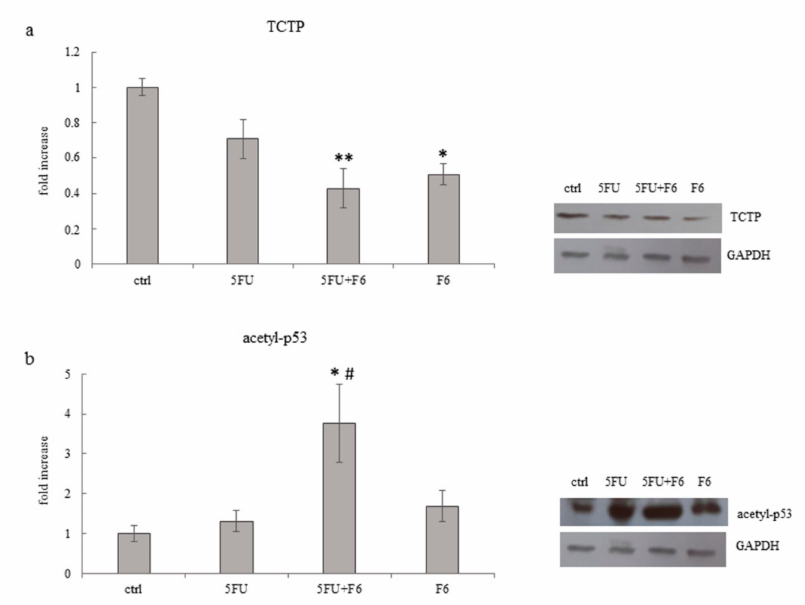
Figure 9. E ff ect of 5FU, 5FU + F6, and F6 on expression of TCTP ( a ) and acetyl-p53 ( b ) in MDA-MB-231 cells. Columns represent densitometric quantification of optical density (OD) of specific protein signal normalized with the OD values of GAPDH served as a loading control and they are expressed as fold increase of control value considered as 1. Each column represents the mean value ± SD of three independent experiments. * p < 0.05; ** p < 0.01 versus ctrl; # p < 0.05 versus 5FU by ANOVA followed by Bonferroni post-test. Representative western blot analysis relating to TCTP and acetyl-p53 expression in MDA-MB-231 cells untreated (ctrl) and treated with 5FU, 5FU + F6, and F6 for 24 h. GAPDH was used as loading